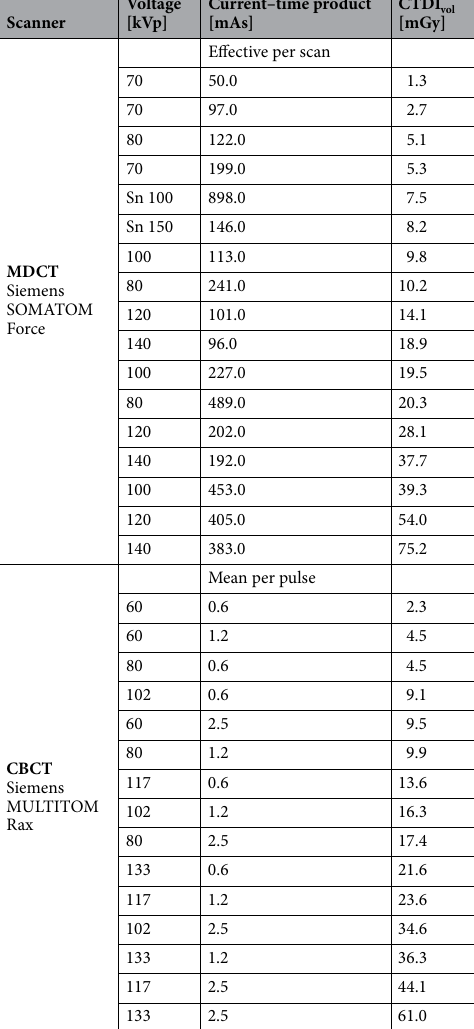
Table 1. Dosimetric comparison of scan protocols. CTDI vol , computed tomography dose index calculated for a 16 cm phantom; CBCT, cone-beam computed tomography; MDCT, multidetector computed tomography; Sn, 0.4 mm tin